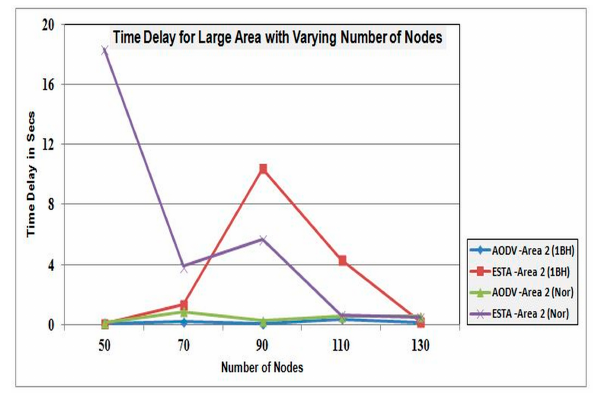
Figure 15. Time delay for varying nodes in a small area.